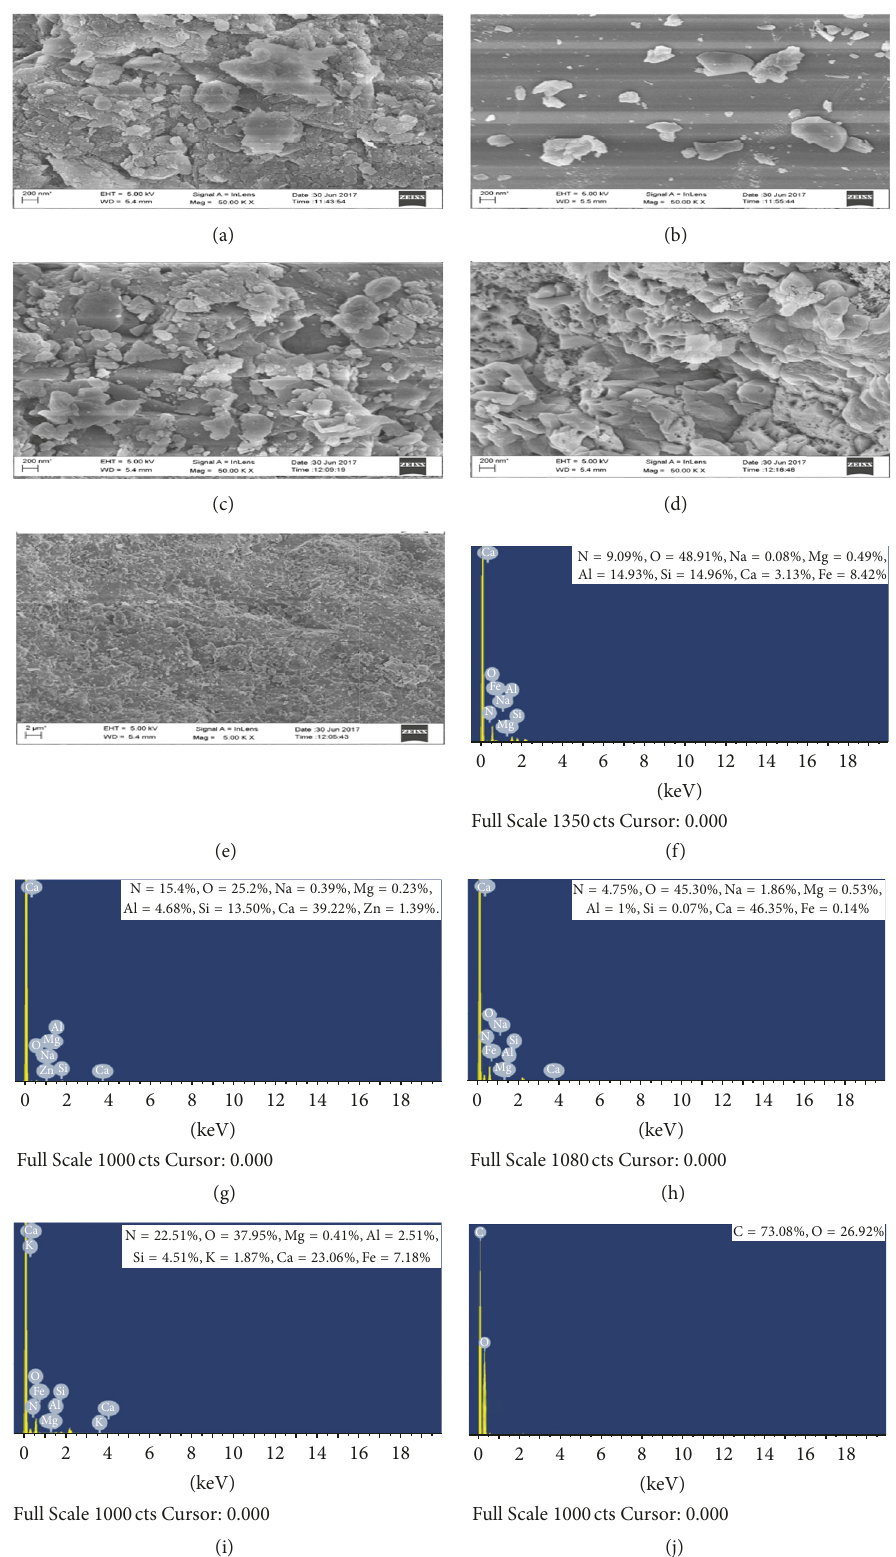
Figure 3: (a)–(e) SEM images of soil, brick dust, stone dust, building demolish dust, and saw dust, respectively, and (f)–(j) EDX patterns of soil, brick dust, stone dust, building demolish dust, and saw dust,